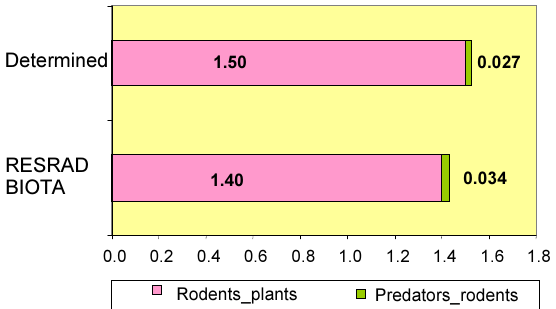
137 Cs accumulation